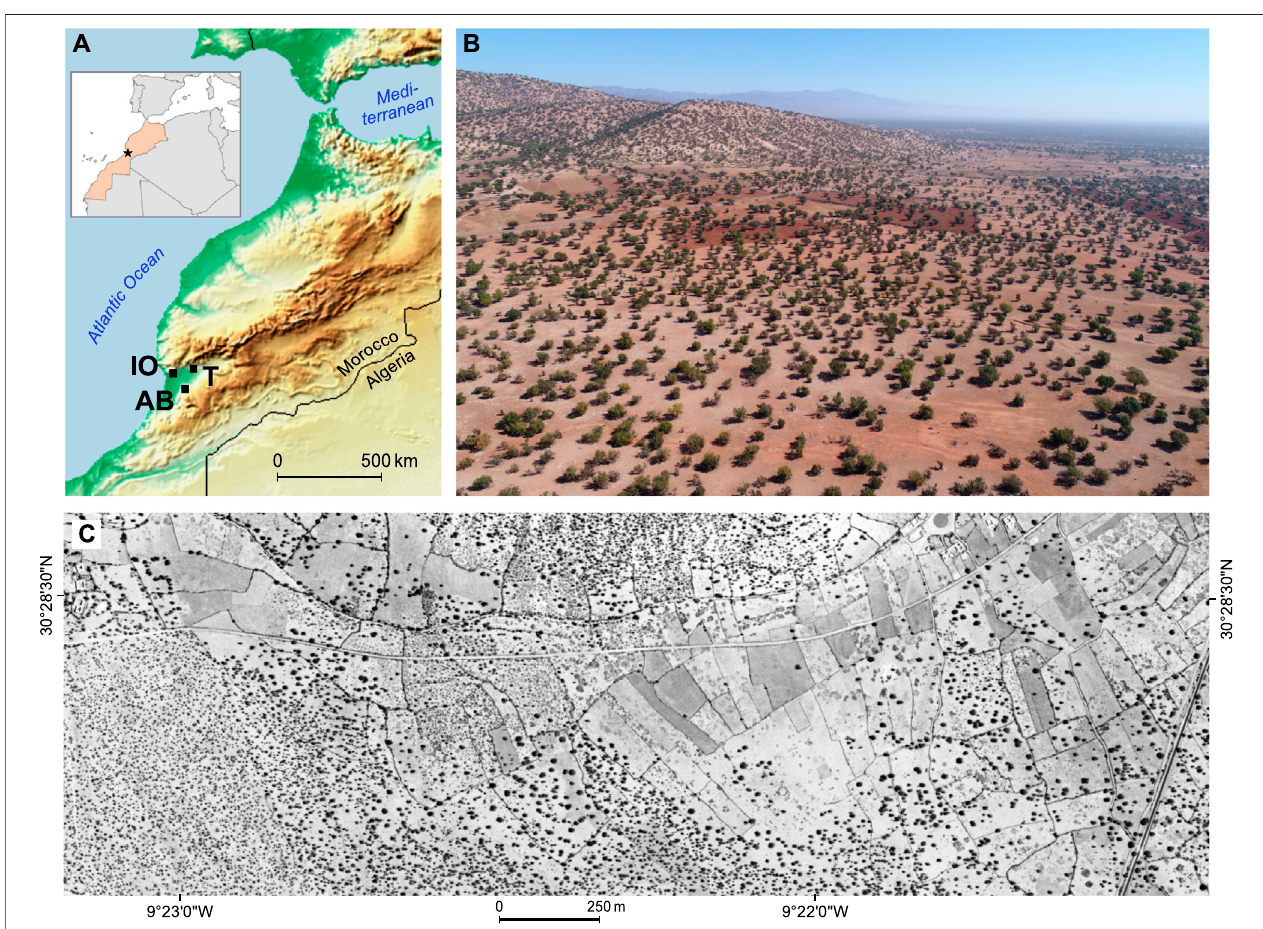
FIGURE 2 |(A) The location of the study areasIda-Outanane (IO), Aït Baha (AB) and Taroudant (T) in the Souss Basin, Morocco. (B) View towards east over argan forests in the foothills of the High Atlas Mountains (Ida-Outanane study area);oblique UAS image ofMarch 2019. Part ofthe area in the middle distance has been freshly ploughed for cereal cultivation, while the woodlands in the foreground are used as silvopasture. The area is classi fi ed as “ 0% trees ” in the 2015 Global Forest Cover Change Map (Sexton et al., 2013). (C) View of the same area in HEXAGON KH-9 stereo-panoramic satellite photograph, 16 July 1972 (subset of image ID D3C1203-200152A016,